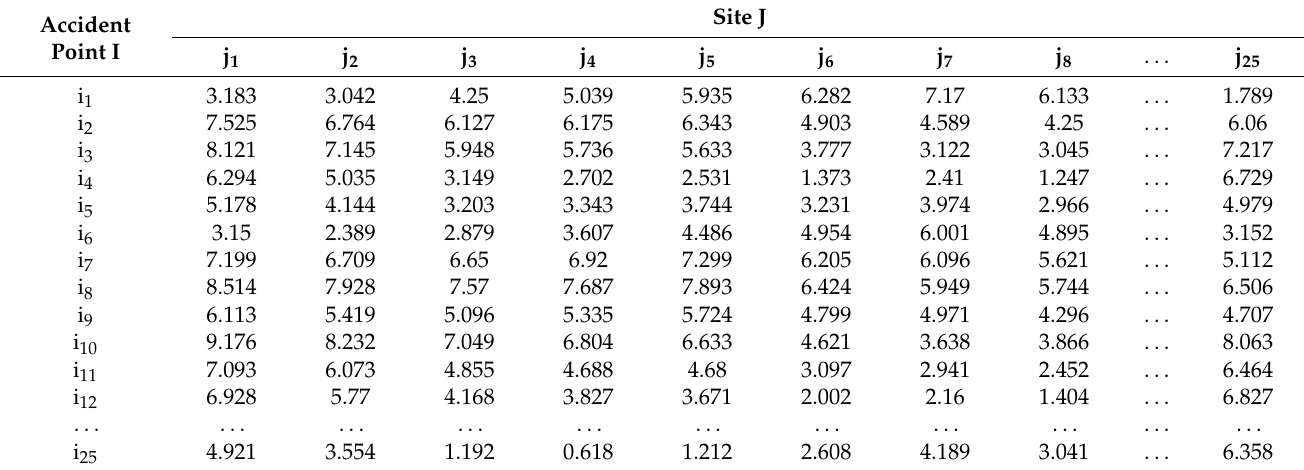
Table 3. Distance from the candidate emergency center to each accident point.